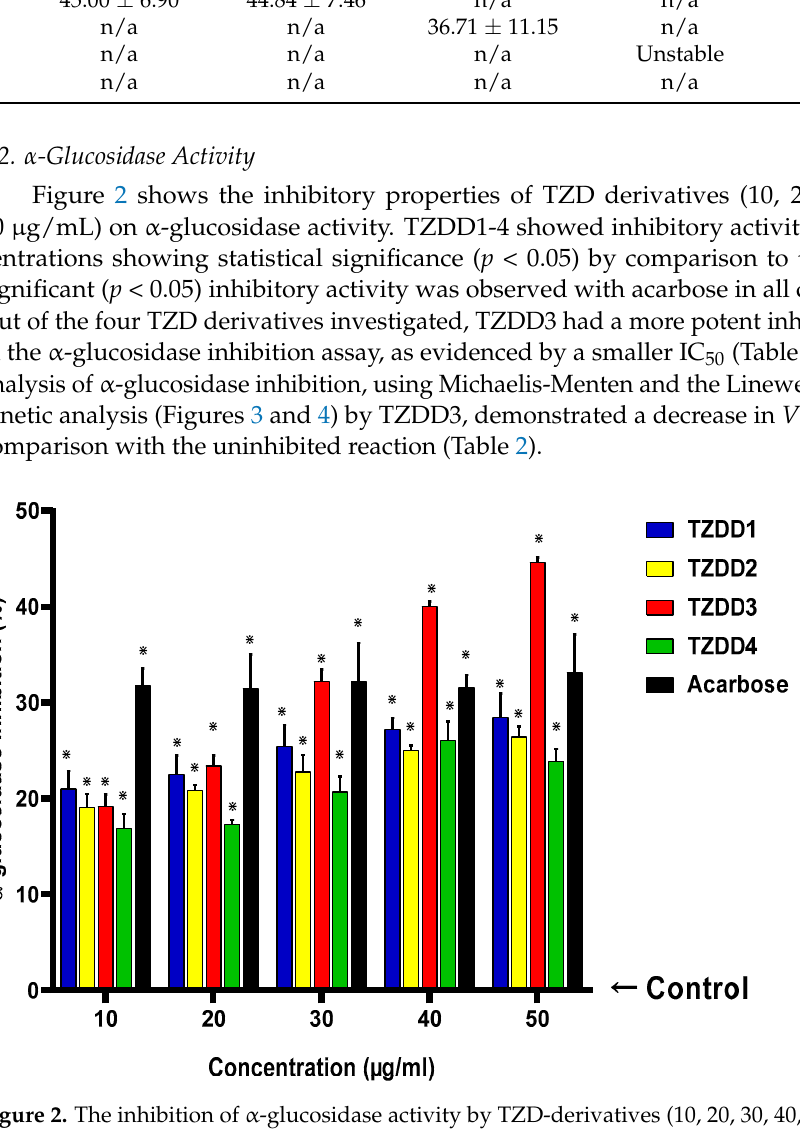
Figure 3. Lineweaver-burk plot of kinetic analysis of α -glucosidase inhibition by TZDD3 at 120 µg/mL.